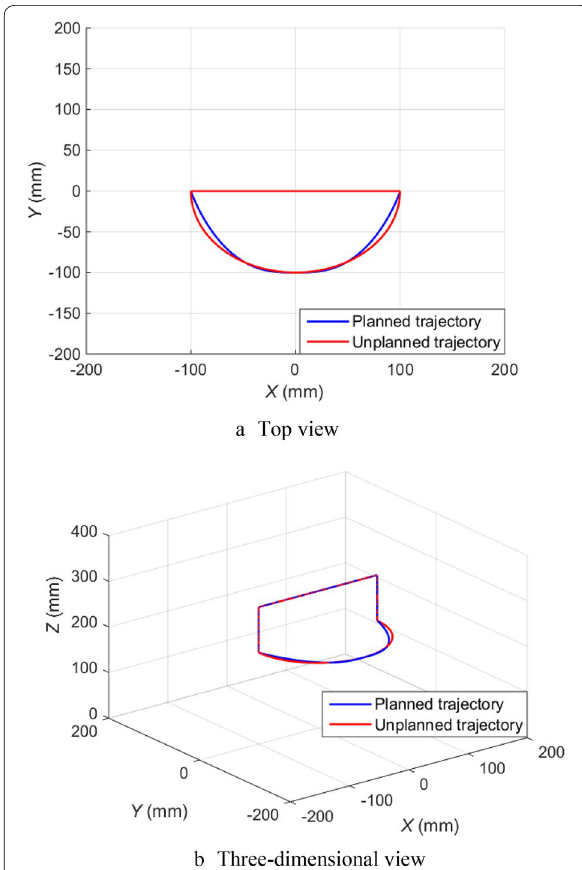
Figure 8 Position, velocity, and acceleration curves of cycloid trajectory planning in the X